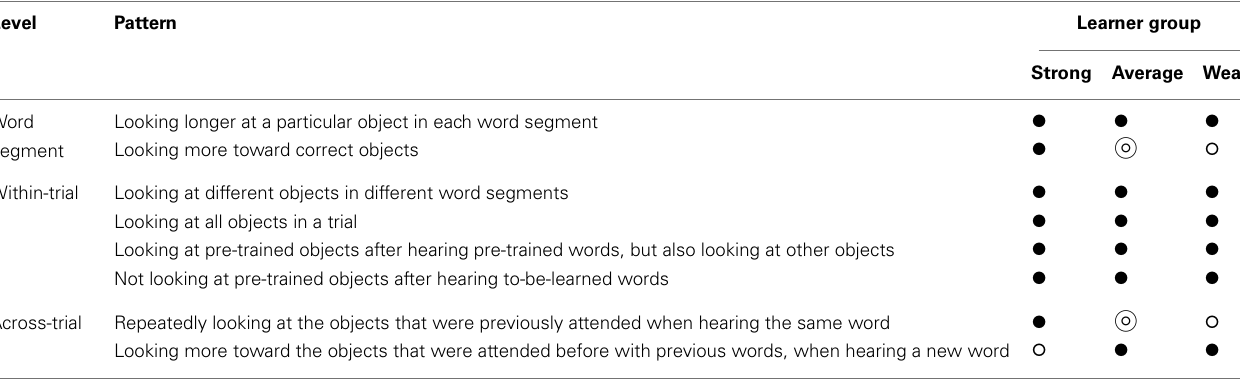
FIGURE 9 | Looking behavior across trials organized by object/word appearance for strong (A), average (B), and weak learners (C). When previous attended objects were not in the current trial co-occurring with the target word, participants had to select a new object.This selection can be Table 1 | Summary of gaze patterns at different temporal levels and from different learner